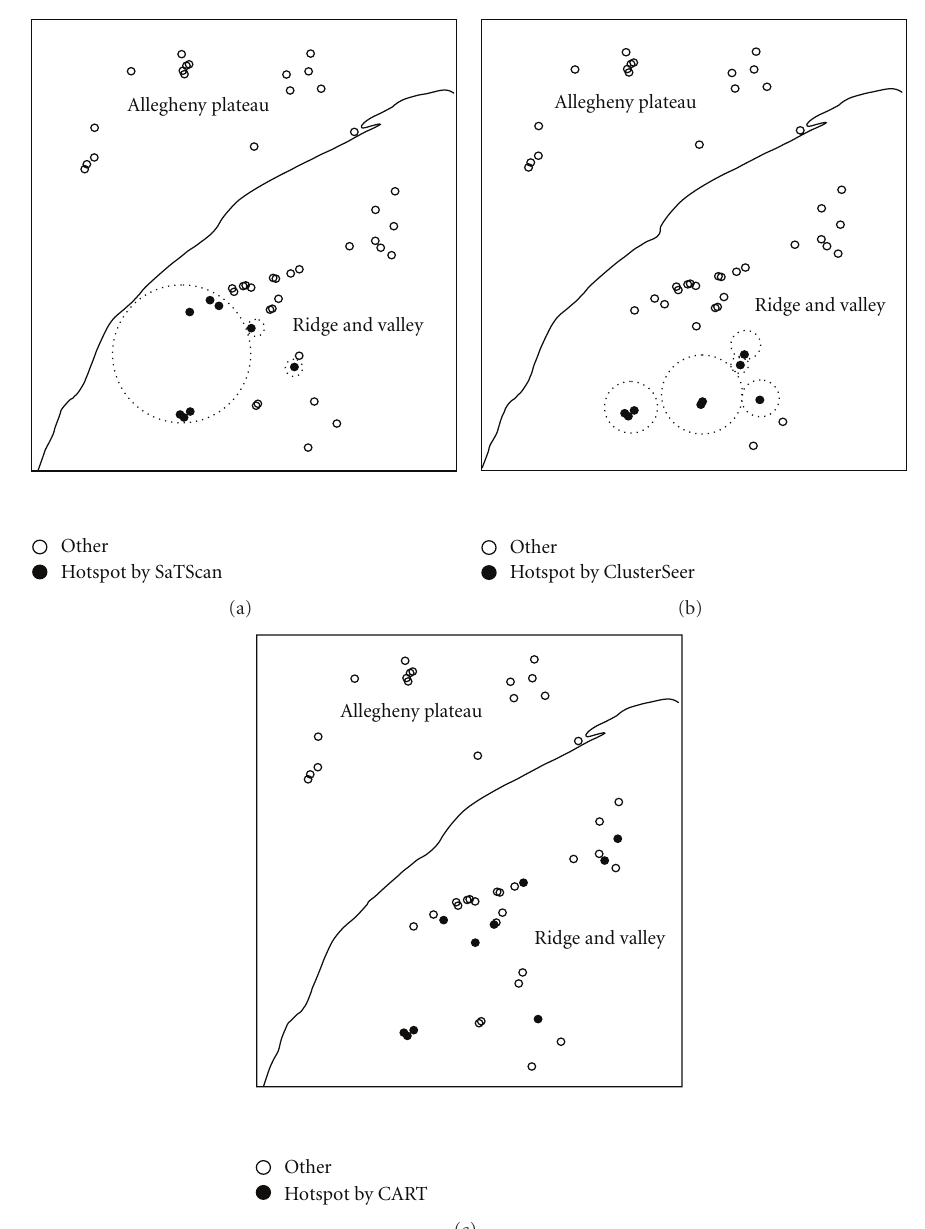
Figure 1: Regional distribution of chestnut oak regeneration hotspots detected by SaTScan (a), ClusterSeer (b), and CART (c). Each dash- line highlighted circle represents a regeneration hotspot.